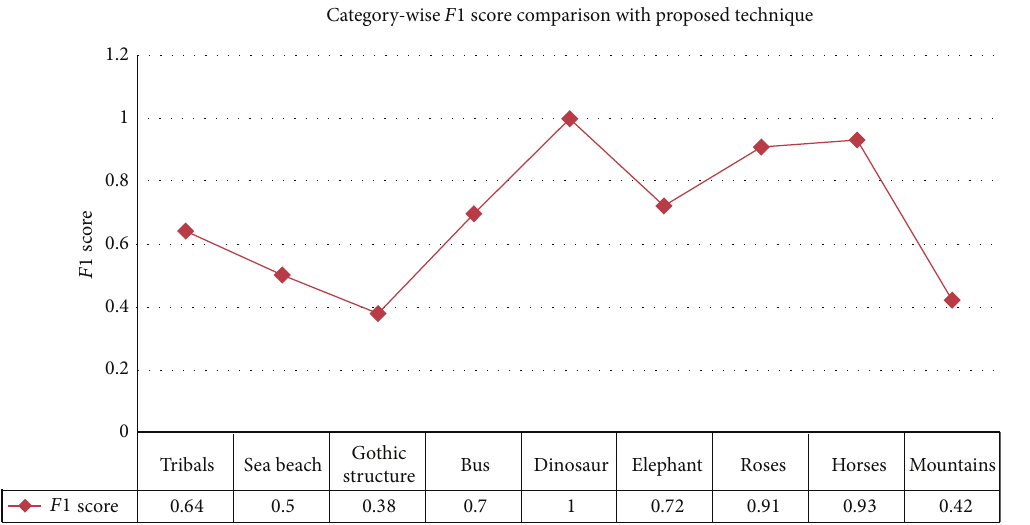
Figure 9: Comparison of 𝐹1 score for different